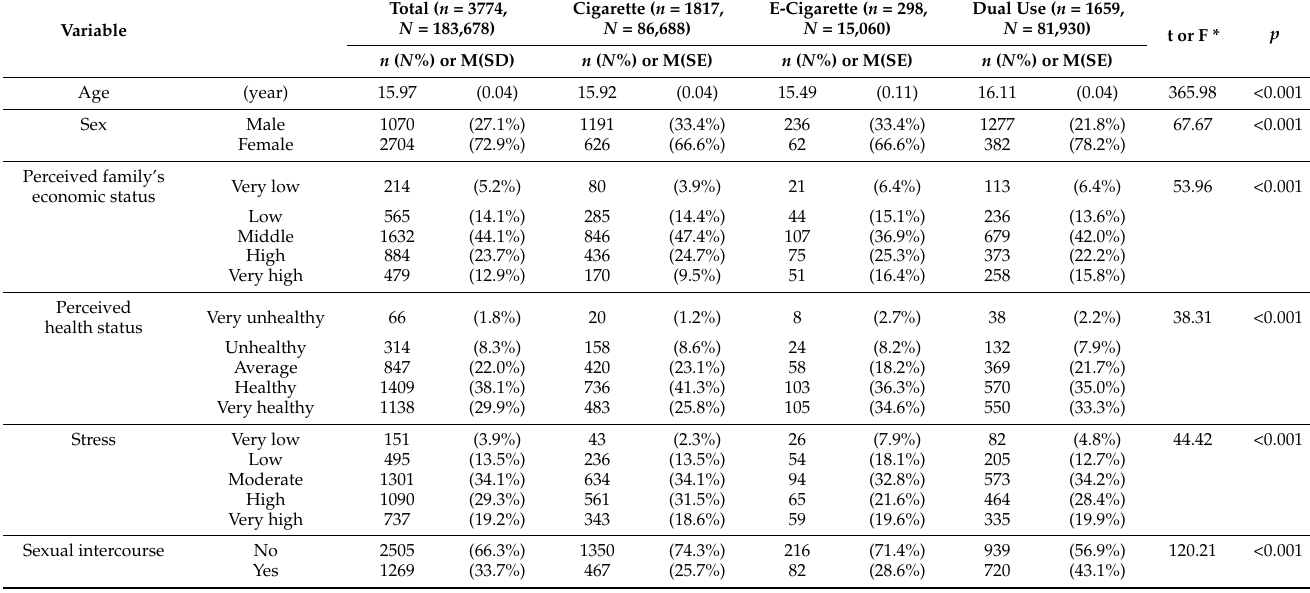
Table 1. Characteristics of participants by tobacco type/form before the COVID-19 pandemic (2019). ( n = 3774, N =